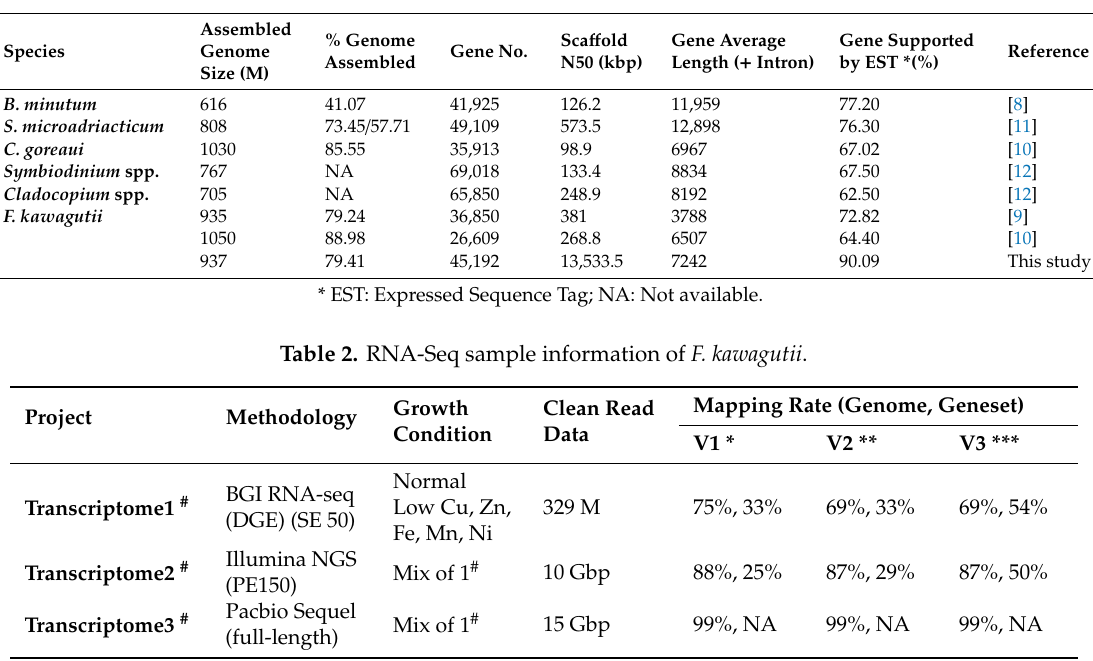
Table 1. Sequenced genomes of Symbiodiniaceae.